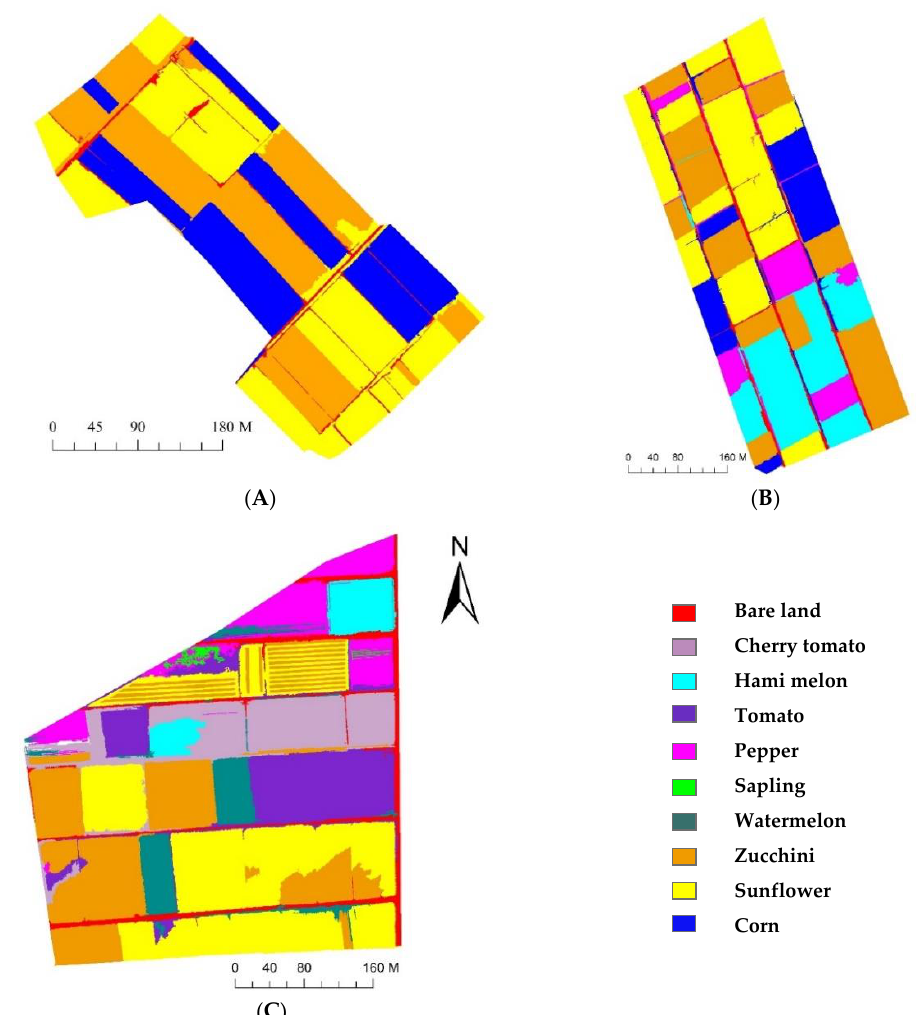
Figure 7. Classification results of OB-RF model. (( A ) classification result of OB-RF model in study area 1; ( B ) classificaTable 2. ( C ) classification result of OB-RF model in study area 3). Note: OB-RF stands for Object-oriented random forest classification model.